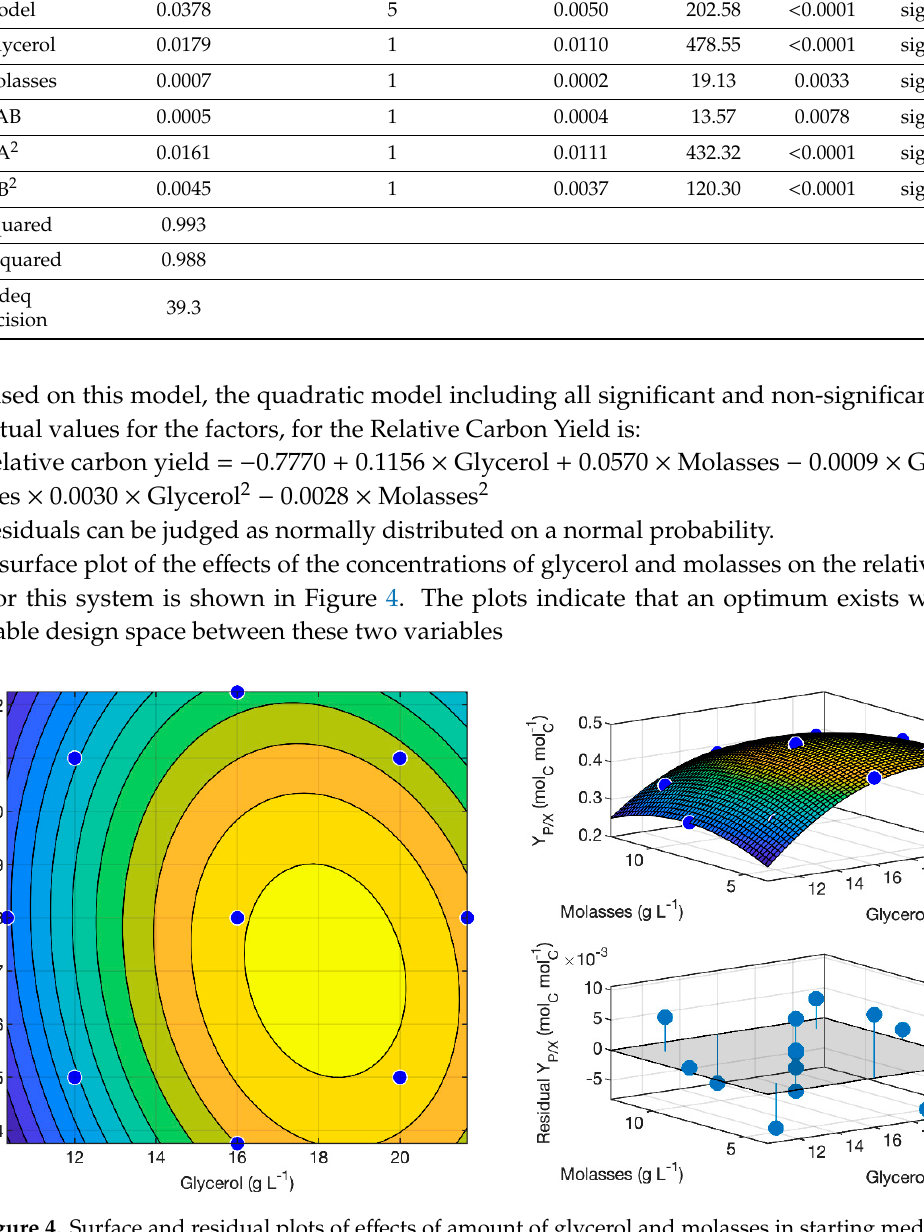
Figure 4. Surface and residual plots of effects of amount of glycerol and molasses in starting media on the relative carbon yield.